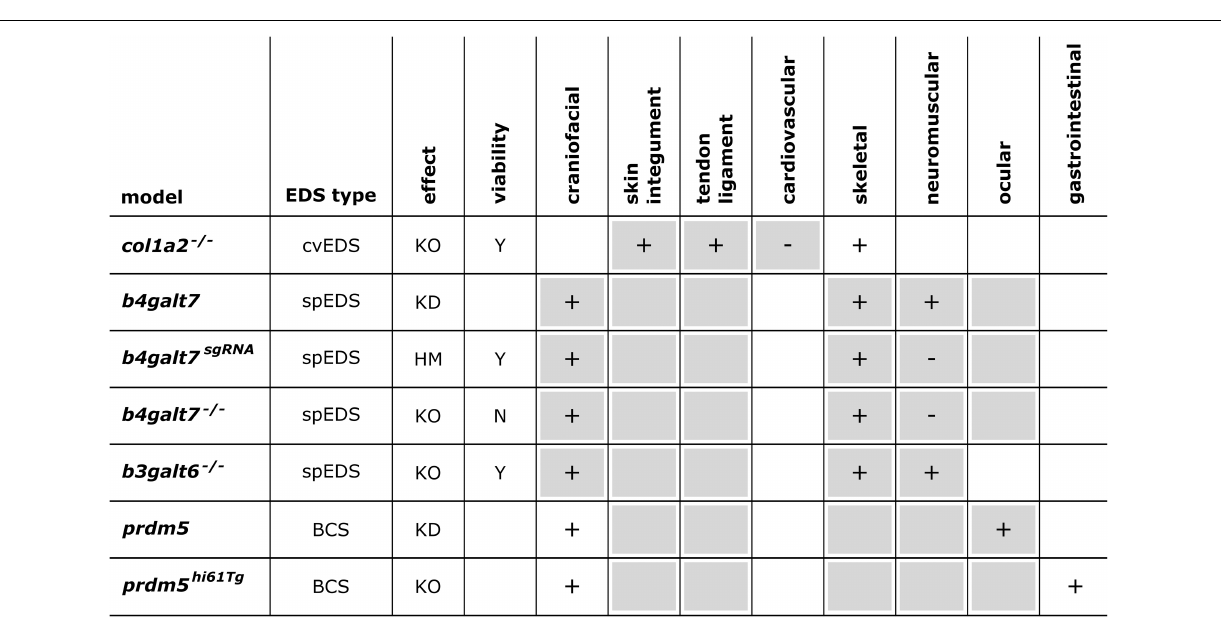
Col5a1 + / − mice also displayed a vascular phenotype with decreased aortic stiffness and breaking strength, however not associated with ruptures or sudden, premature death